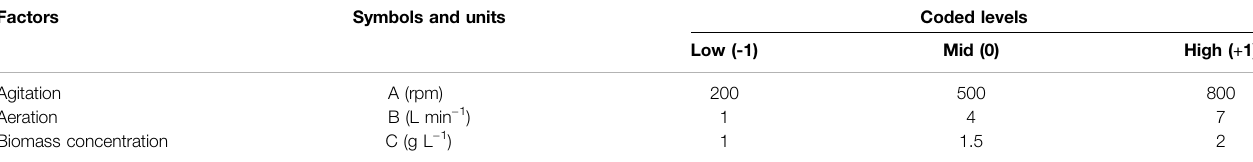
TABLE 1 | Experimental range of variables studied during designing of experiments.